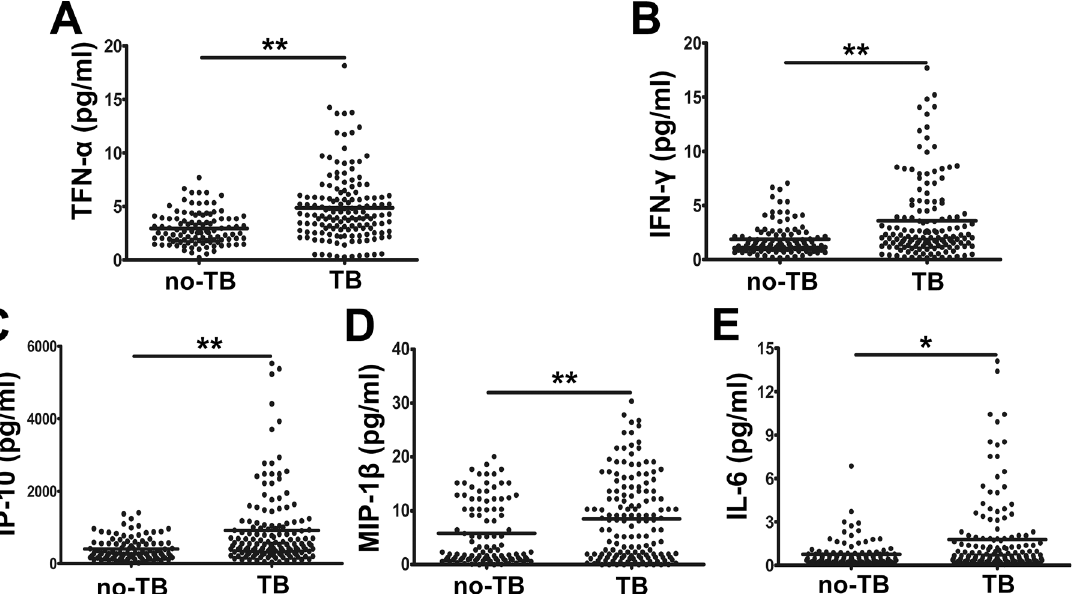
Fig 1. Representative plasma cytokine/chemokine expression levels in TB patients ( n = 151) and no-TB donors ( n = 107). (A) TNF- α , (B) IFN- γ , (C) IP-10/CXCL-10, (D) MIP-1 β , and (E) IL-6 levels. * P < 0.05, ** P < 0.001. P : P value. Independent-sample T testing was performed to compare the results from TB patients with those of no-TB